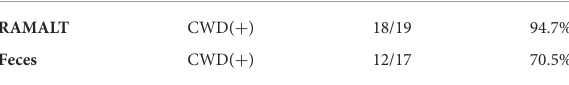
TABLE 1C CWD detection with RT QuIC in RAMALT and feces for white-tailed deer with prion detection CWD ( + ) in both lymph node and obex with immunohistochemistry.